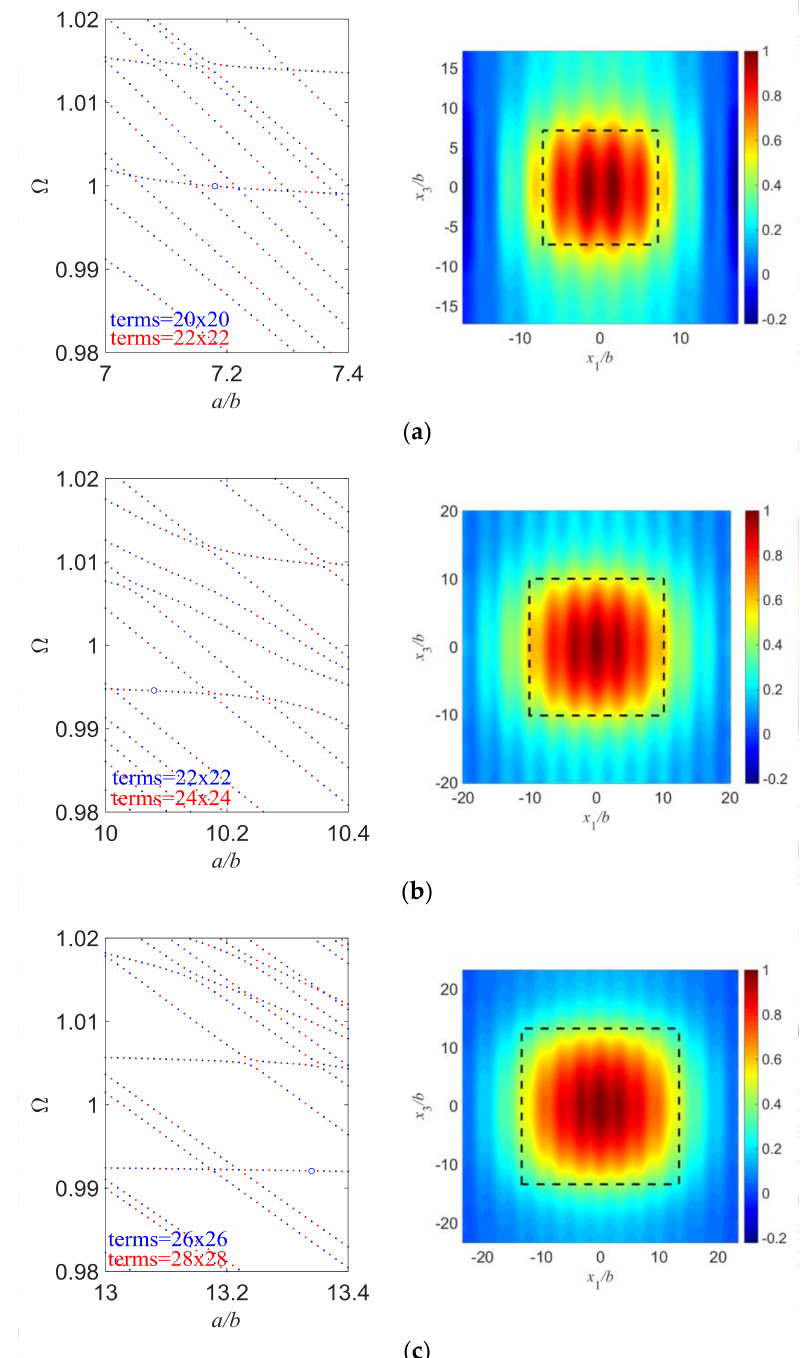
Figure 5. Essential TS modes with different a / b . ( a ) a / b = 7.18, d / b = 10, R = 0.01, Ω = 0.99995715; ( b ) a / b = 10.08, d / b = 10, R = 0.01, Ω = 0.99455566; ( c ) a / b = 13.34, d / b = 10, R = 0.01, Ω =